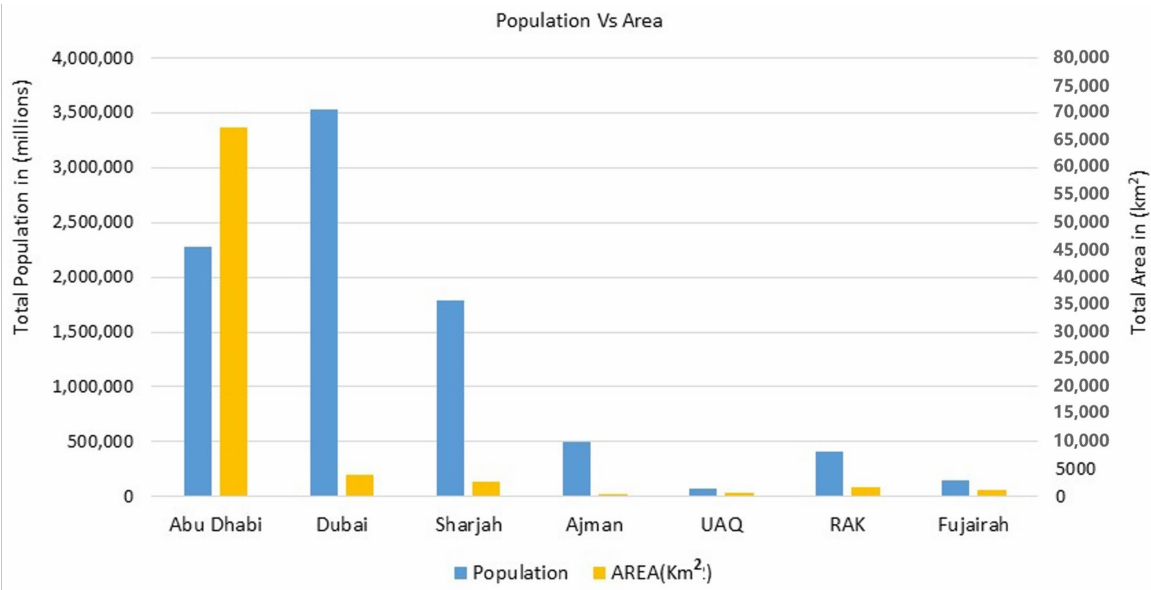
Figure 3. Bar graph indicating total area of each emirate vs. reclaimed area of each emirate.